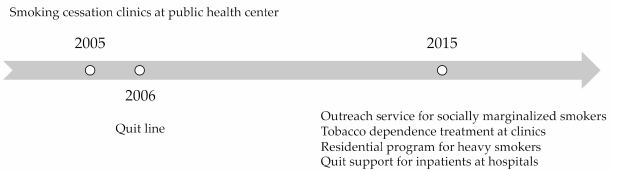
Figure 1. Introduction of national tobacco cessation support in the Republic of